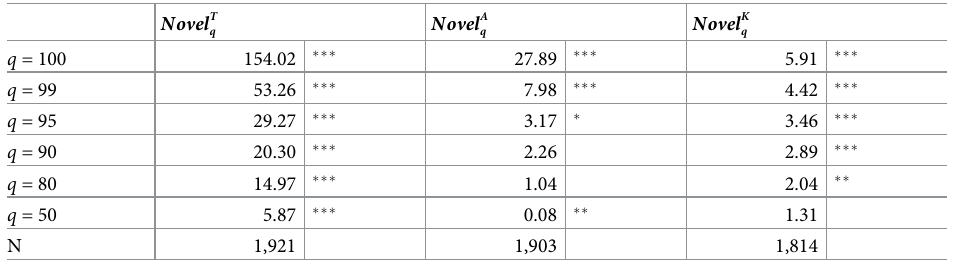
Table 5. Odds ratio of top-1% citation